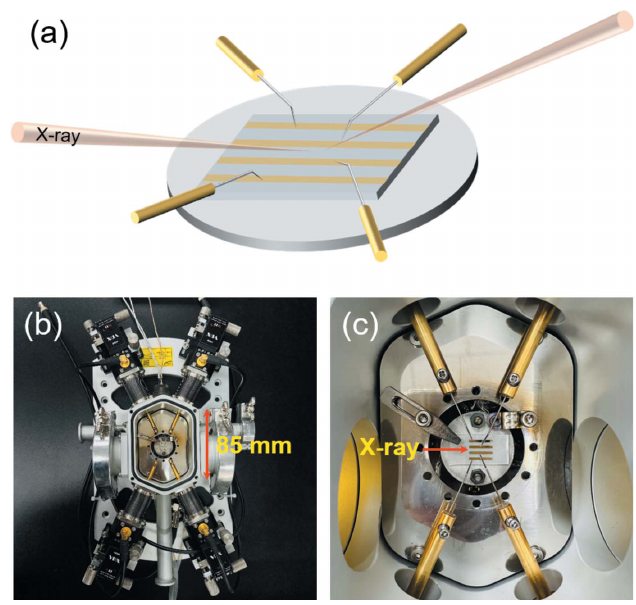
Figure 4 ( a ) Schematic of the operation of four-point probe and XRD measurements. ( b ) X-ray probe station, which weighs approximately 8 kg. Probe holders are adjusted by x - y - z stages. ( c ) Example of sample loaded for multimodal measurements. The probe tips are in contact with metal